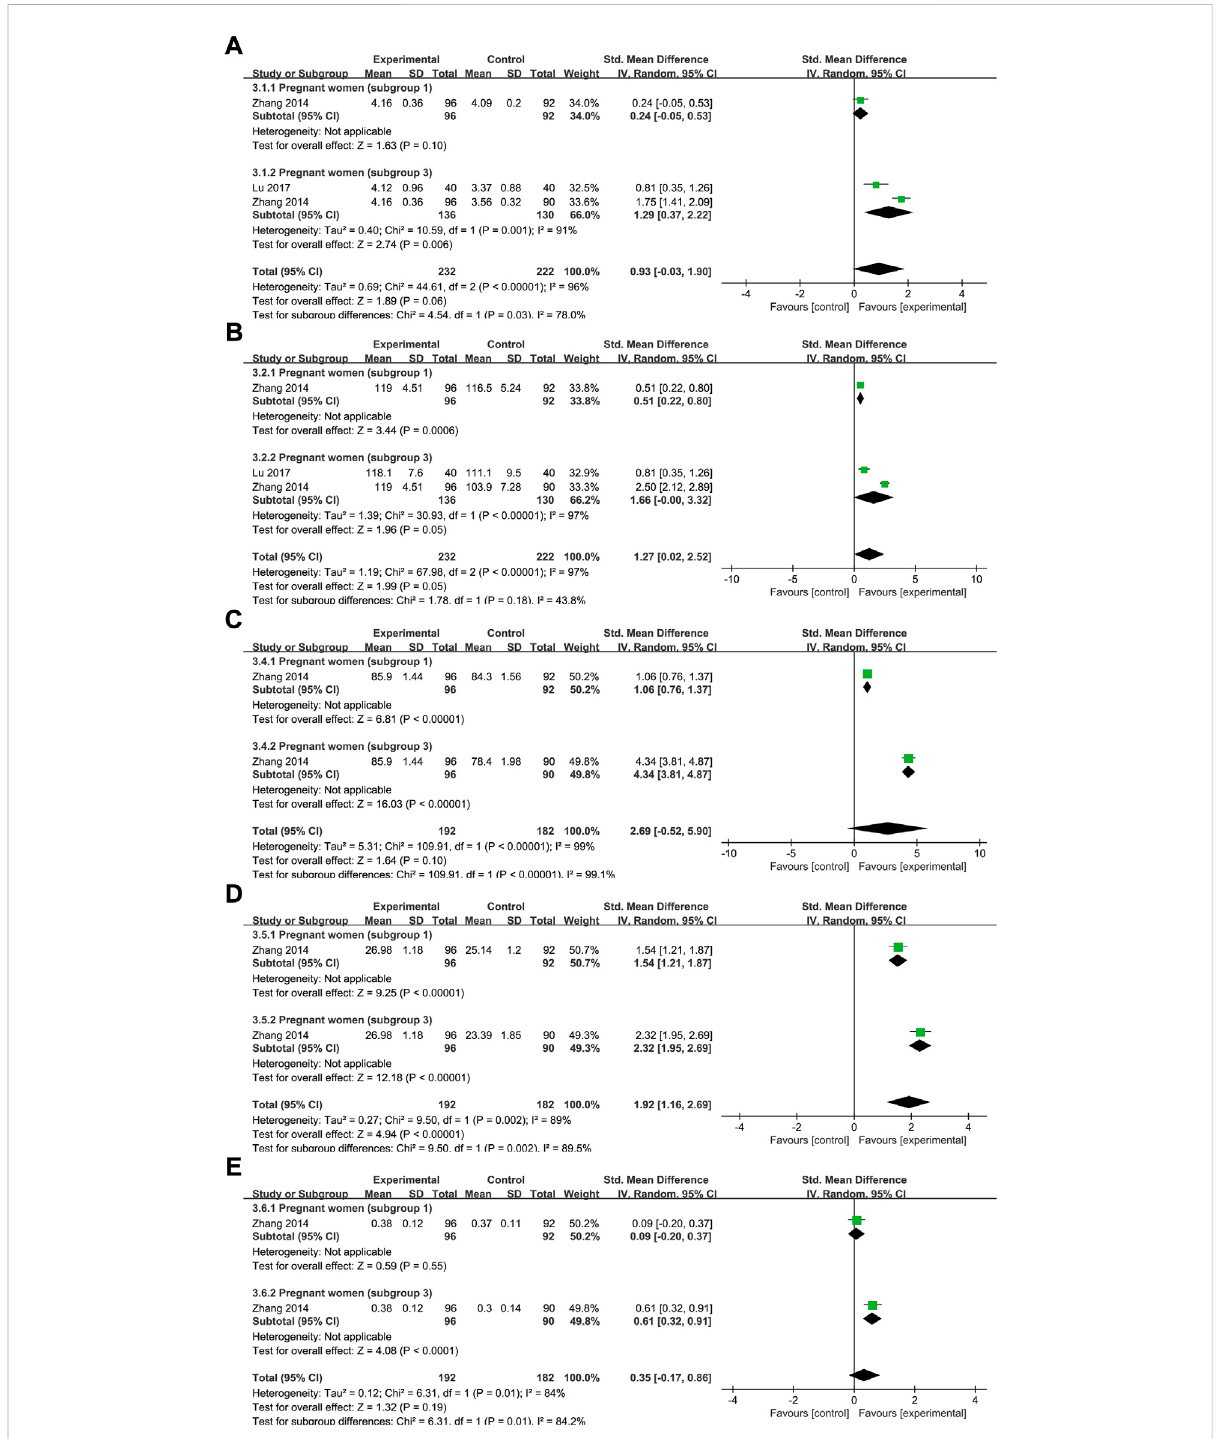
FIGURE 11 TheforestplotassessingtheeffectofSXNinpreventingIDAduringpregnancy (involvingsubgroup1andsubgroup3)intermsofRBCcount (A) , Hb (B), MCV (C) MCH (D) , and HCT (E)